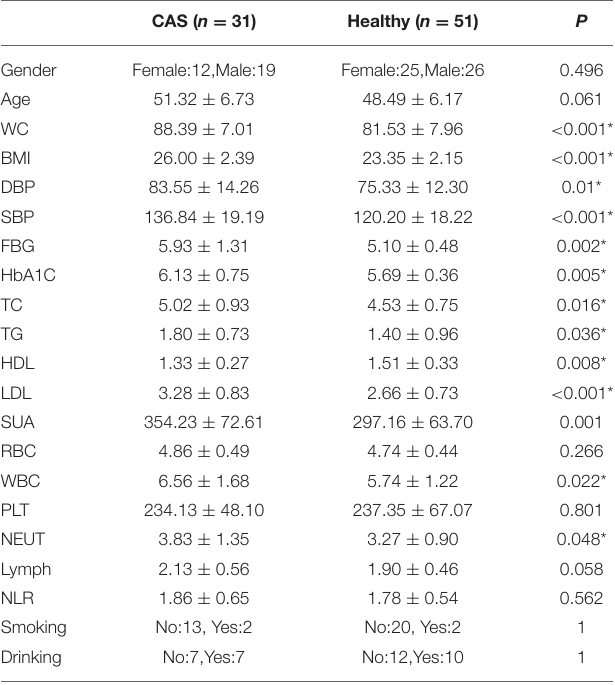
TABLE 1 | The major demographic and serum characteristics of patients with CAS and healthy